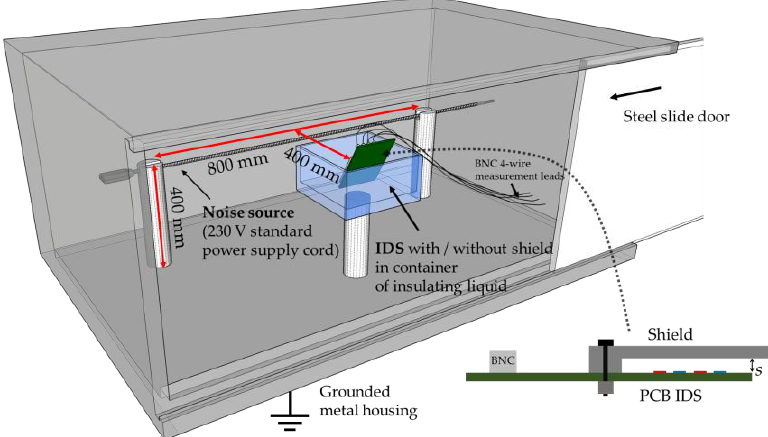
Figure 9. Experimental arrangement of the setup to test the function of the shield onto the IDS at distance s 0 = 1.5 λ . Relevant dimensions are shown.